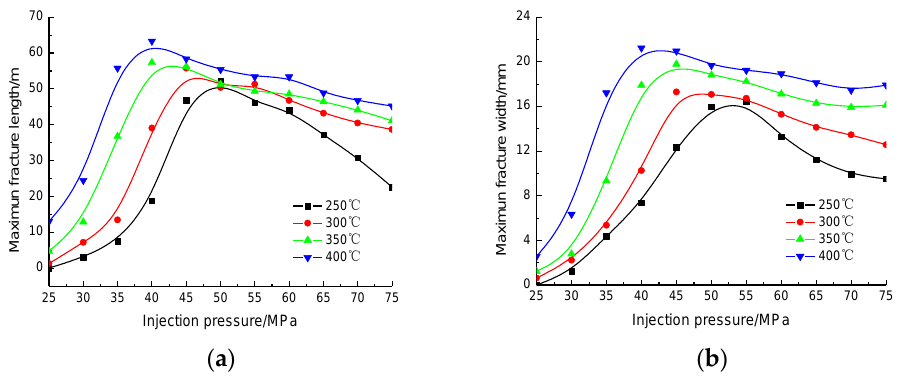
Figure 10. The relation between fracture length and width and injection pressure. ( a ) Fracture length curves. ( b ) Fracture width curves.